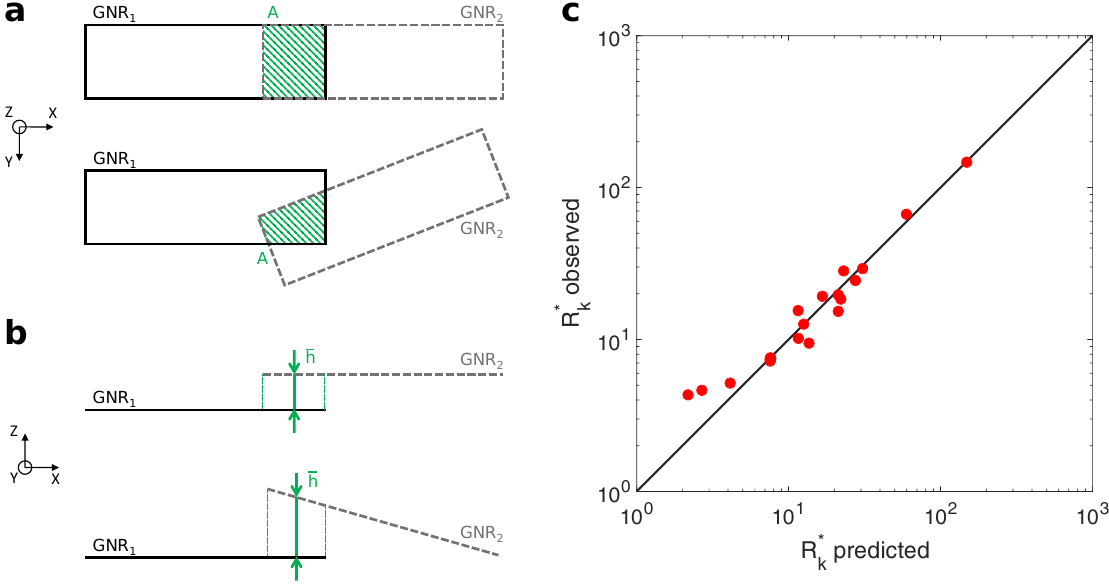
Figure 4. ( a ) Examples of projected overlapping area ( A , green texture) between GNR 1 (solid black line) and GNR 2 (dashed grey line) nanoribbons. ( b ) Examples of average interplanar spacing (¯ h , green line) between GNR 1 (solid black line) and GNR 2 (dashed grey line) nanoribbons. ( c ) Reduced value = R k λ of Kapitza resistance at the GNR-GNR interface ( R ∗ ): predicted values from the best-fitted L k Equation (5) vs. observed values by Molecular Dynamics (MD)